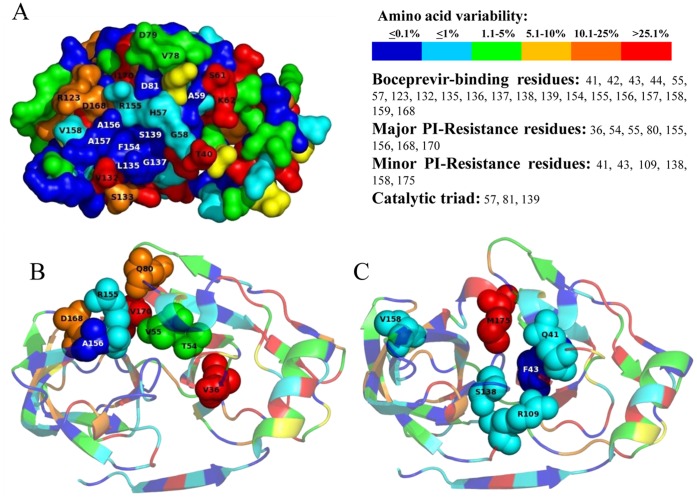
Conservation of HCV NS3 protease from PI-naïve HCV infected patients.Panel (A) reports the molecular surface structure of HCV-1b NS3-protease, colored according to the frequency rate of mutations observed in all 1568 HCV-sequences. The catalytic-triad and residues located inside and in proximity of the hydrophobic-core of the NS3-protease are reported. Panels (B) and (C) show a co-crystalized boceprevir-HCV-1a protease structure, colored according to the amino acid conservation observed in all HCV-sequences.